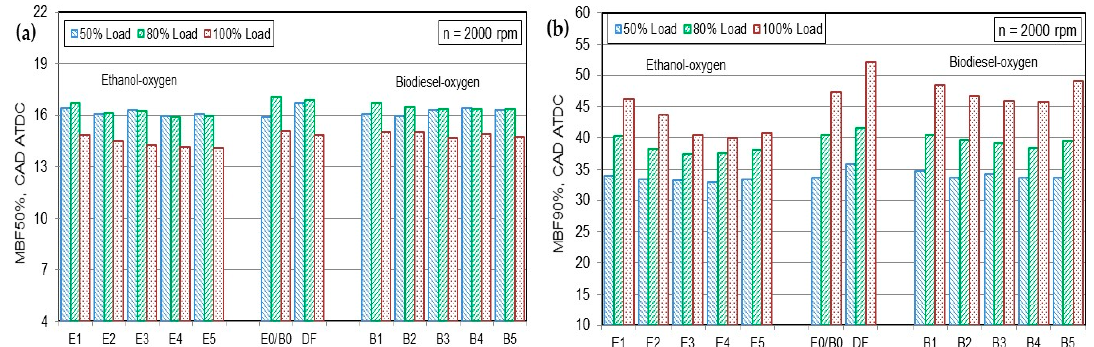
Figure 6. Crank angles of mass burn fractions MBF 50 ( a ) and MBF 90 ( b ) as a function of ethanol–oxygen or biodiesel-oxygen mass content (wt%) in fuel blends measured when running under medium (50%), intermediate (80%), and full (100%) loads corresponding to IMEPs of 0.75, 1.20, and 1.50 MPa developed at speed of 2000 rpm.